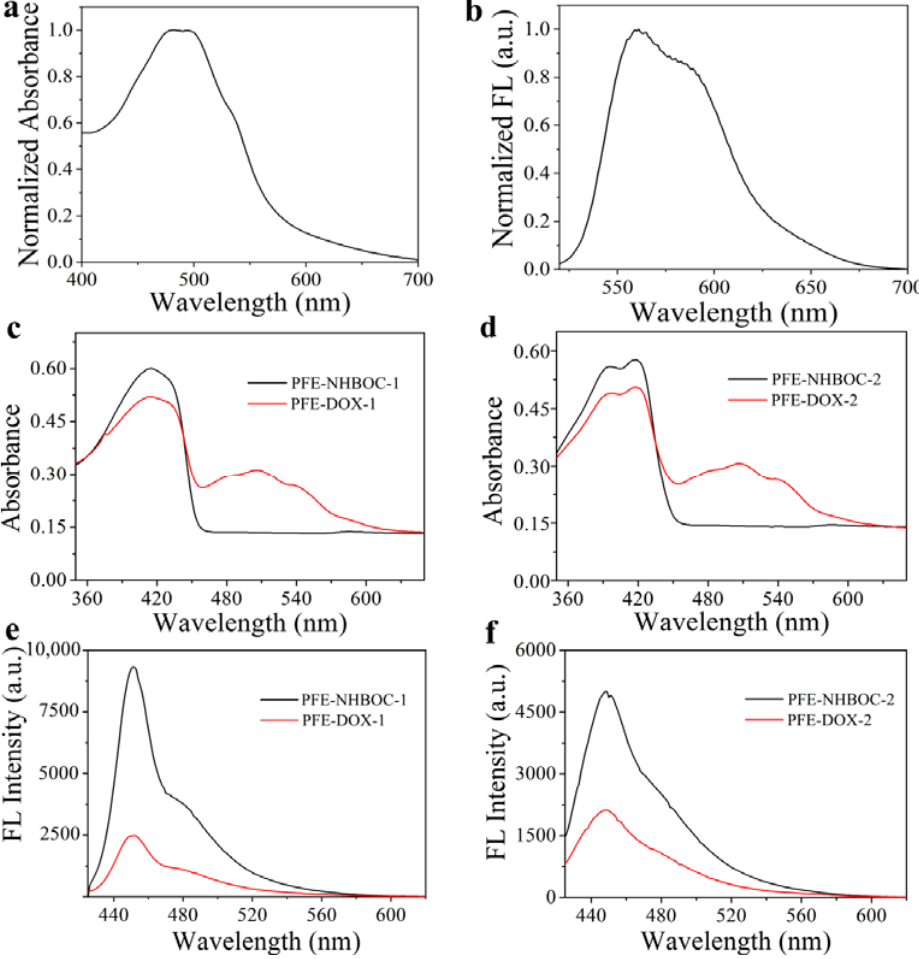
Figure 2. ( a ) Normalized absorption spectrum and ( b ) normalized fluorescence spectrum of DOX. Absorption spectra of conjugated polymers ( c ) PFE ‐ NHBOC ‐ 1 and ( d ) PFE ‐ NHBOC ‐ 2 before and Absorption spectra of conjugated polymers ( c ) PFE-NHBOC-1 and ( d ) PFE-NHBOC-2 before and after DOX modification. Fluorescence spectra of ( e ) PFE ‐ NHBOC ‐ 1 and ( f ) PFE ‐ NHBOC ‐ 2 before after DOX modification. Fluorescence spectra of ( e ) PFE-NHBOC-1 and ( f ) PFE-NHBOC-2 before and and after DOX modification. after DOX